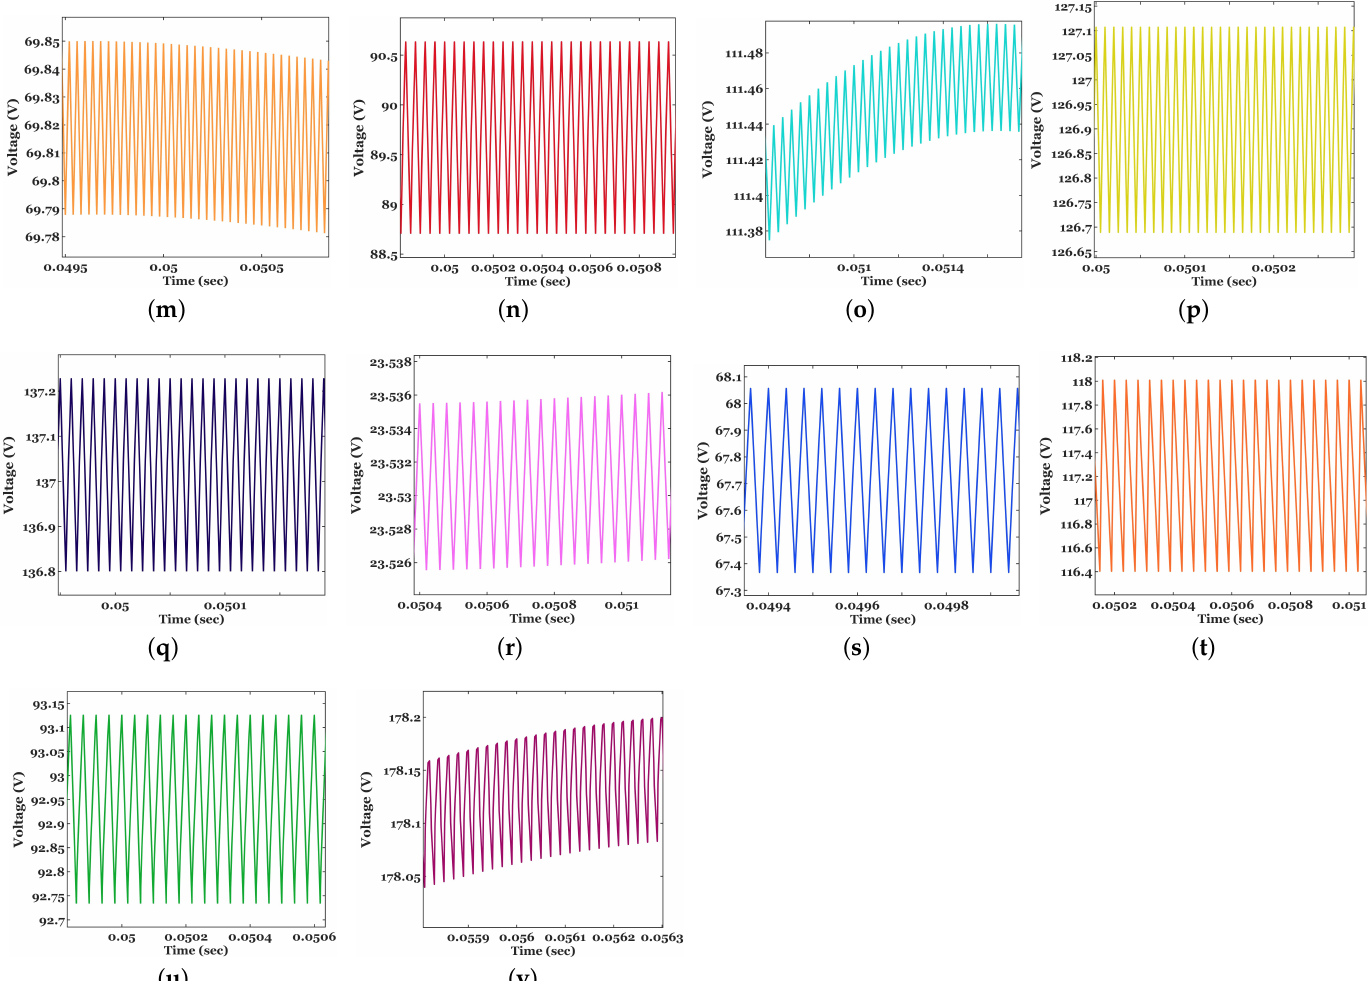
Figure 29. Voltage Ripple ( a ) DBC ( b ) TBC ( c ) 1st M-TBC ( d ) DuBC ( e ) TLBC ( f ) 1st M-TLBC ( g ) 2nd M-TLBC ( h ) 2-IBC ( i ) 4-IBC ( j ) 1st M-IBC ( k ) 2nd M-IBC ( l )